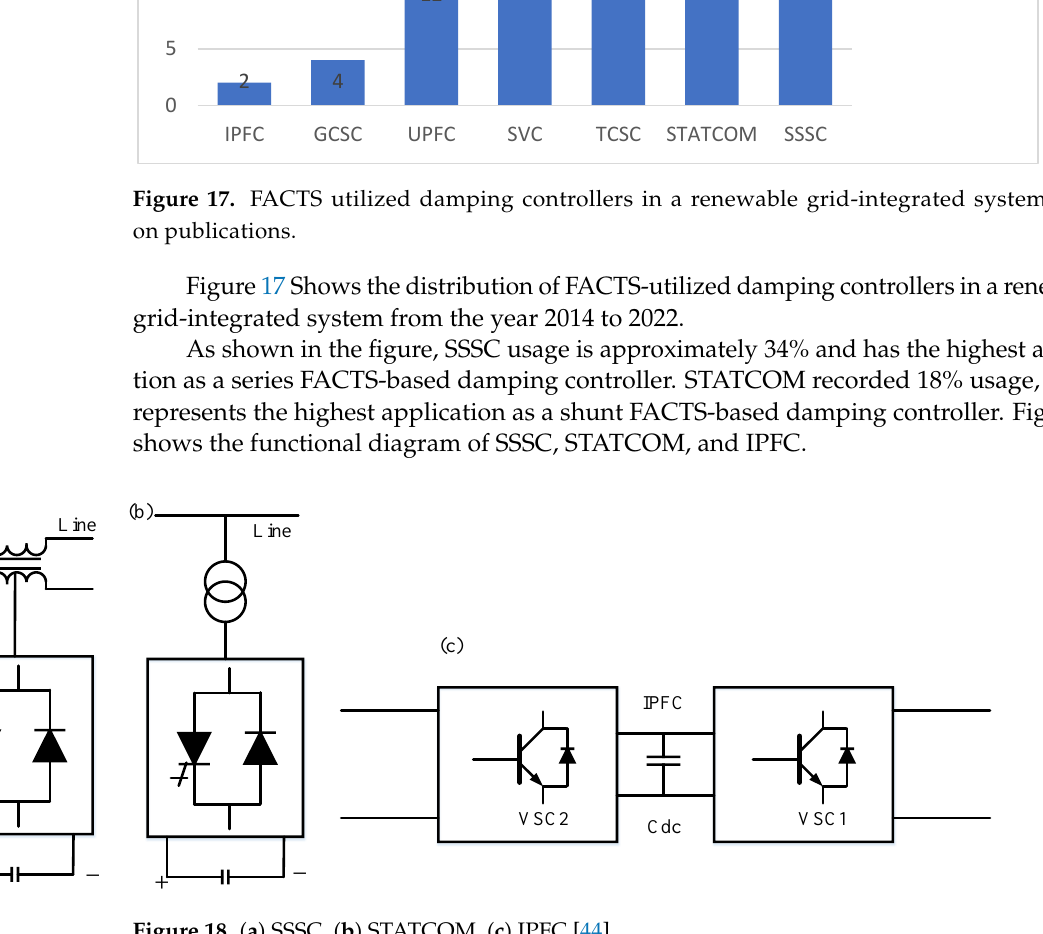
Figure 19. Sugeno type two input NFC structure [44].